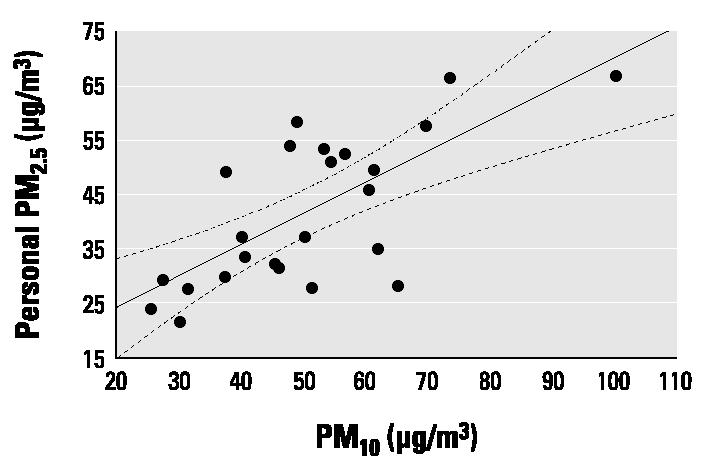
Correlation between mean monthly personal PM2.5 measurements and mean monthly PM10 concentrations from areawide ambient monitoring (circles). Solid line, regression; dashed lines, 95% CI.